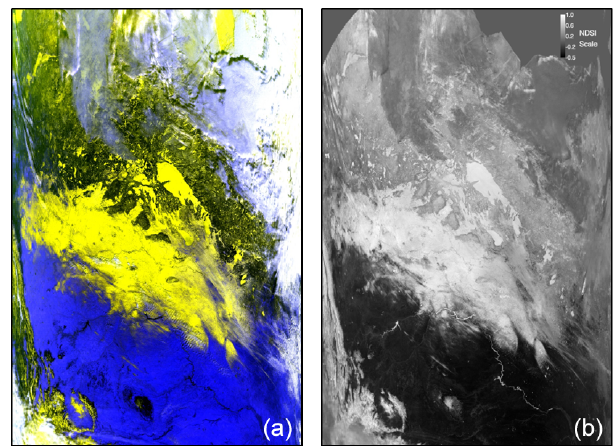
Figure 2. MODIS NDSI. Swath of MOD10_L2 NDSI dataset (b) for 10 January 2003 17:50UTC compared to false color display of MOD02HKM bands 1, 4 and 6 (a) with snow-covered landscape in hues of yellow. NDSI data in the range of − 1.0 to 1.0; clouds are not masked,while oceans and night are masked. Swath covers cen- tral Canada, Lake Winnipeg near the center of the image, and the Plains of the USA. Snow-covered forest, snow-covered plains and snow-free plains are seen in this